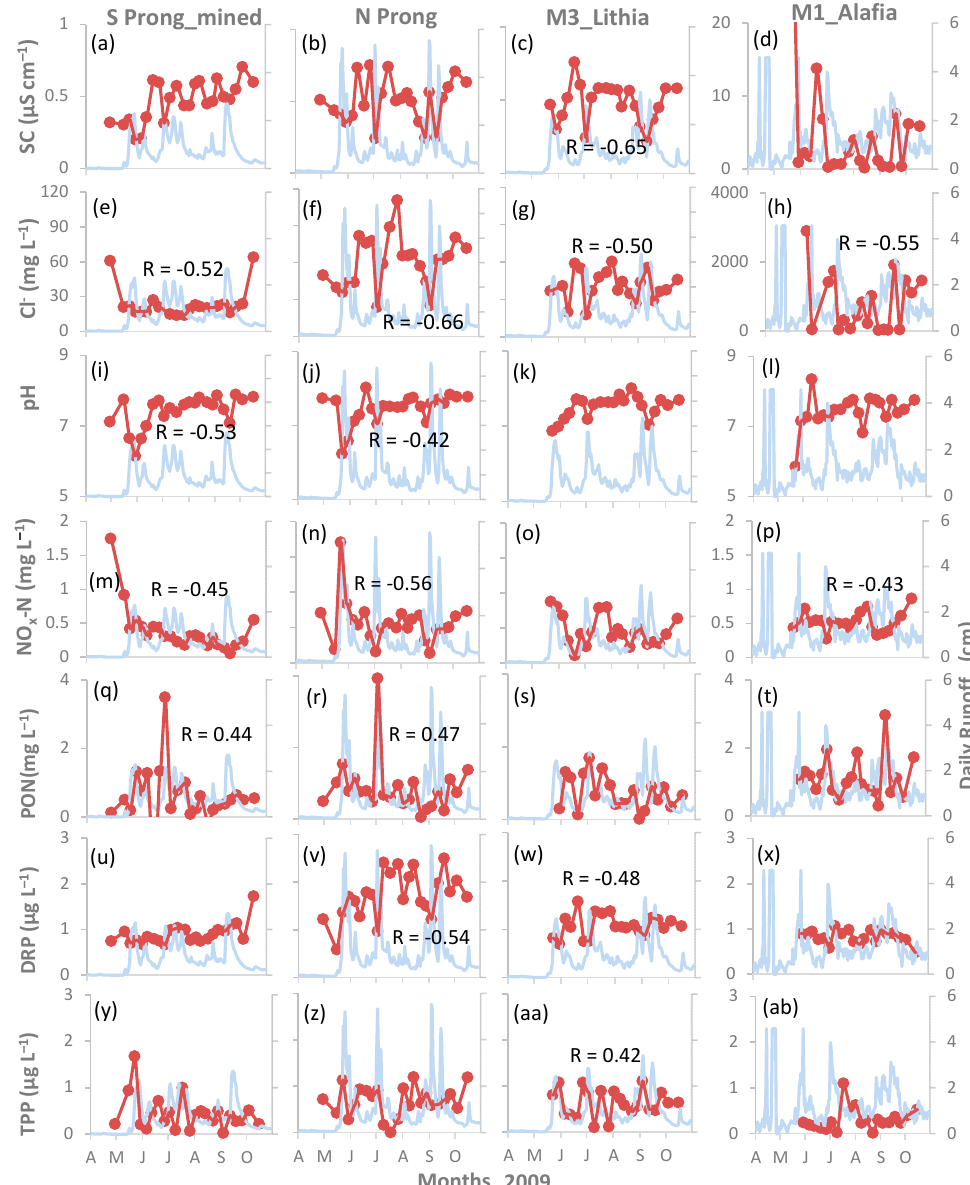
Figure 6. Temporal variability (April to October 2009) of ( a – d ) specific conductance (SC), ( e – h ) chloride (Cl − ), ( i – l ) pH, ( m – p ) NO x -N, ( q – t ) PON, ( u – x ) DRP, and ( y – ab ) TPP in four sub-basins (South Prong, North Prong, mainstem sites M3 at Lithia and M1 at Alafia). Water quality variable scales (red) are marked on the primary y -axis, while daily runoff (light blue) is marked on the secondary y -axis. A, M, J, J, A, S, and O on the x -axis are abbreviations for April, May, June, July, August, September, and October, respectively. Correlation coefficient (R) is included when there was a significant relationship with daily runoff. PON: particulate organic N, DRP: dissolved reactive P, and TPP: total particulate P.